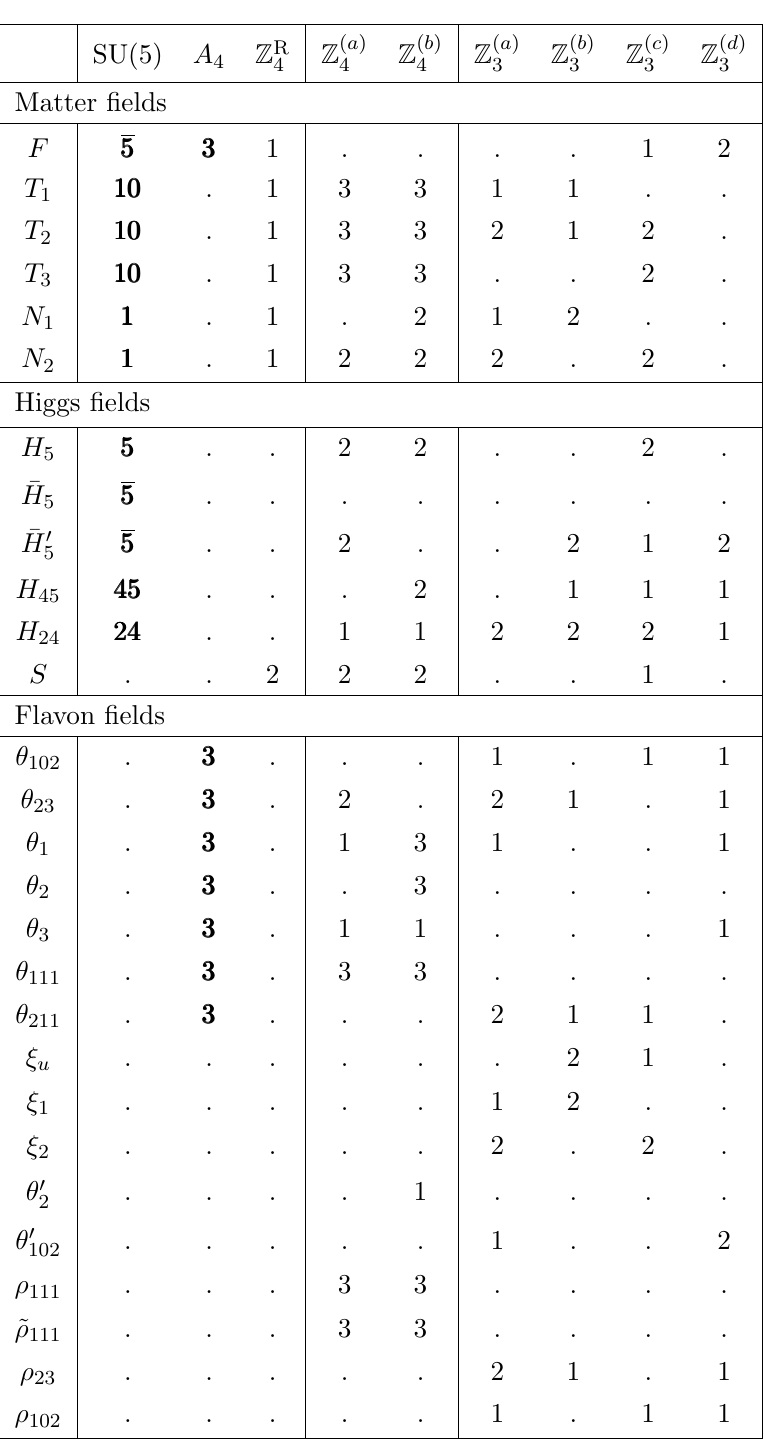
Table 3 . The matter, Higgs and (cid:13)avon (cid:12)eld content of our model. A dot means that the (cid:12)eld is an invariant singlet under the respective